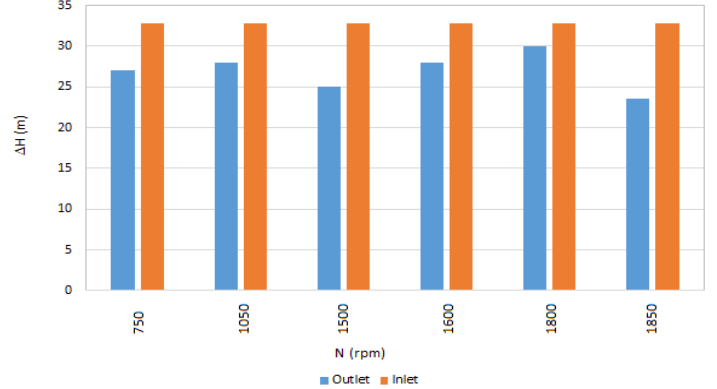
Figure 4. Comparison in terms of total pressure drop between inlet and outlet rotor.